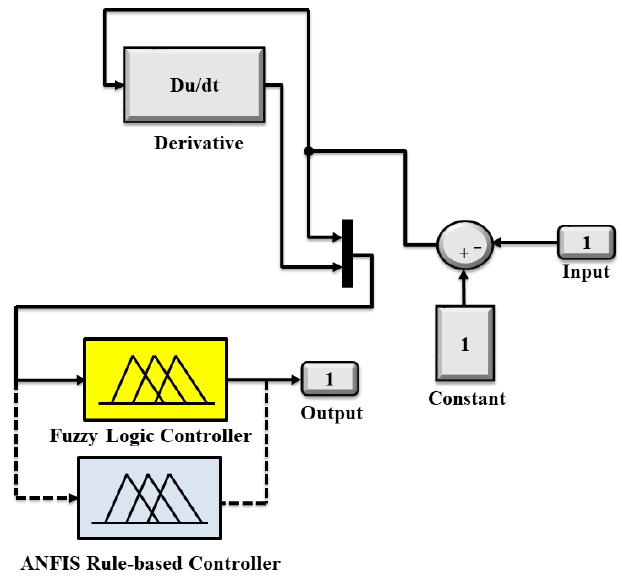
Figure 17. The FLC and ANFIS of HFC D-STATCOM.